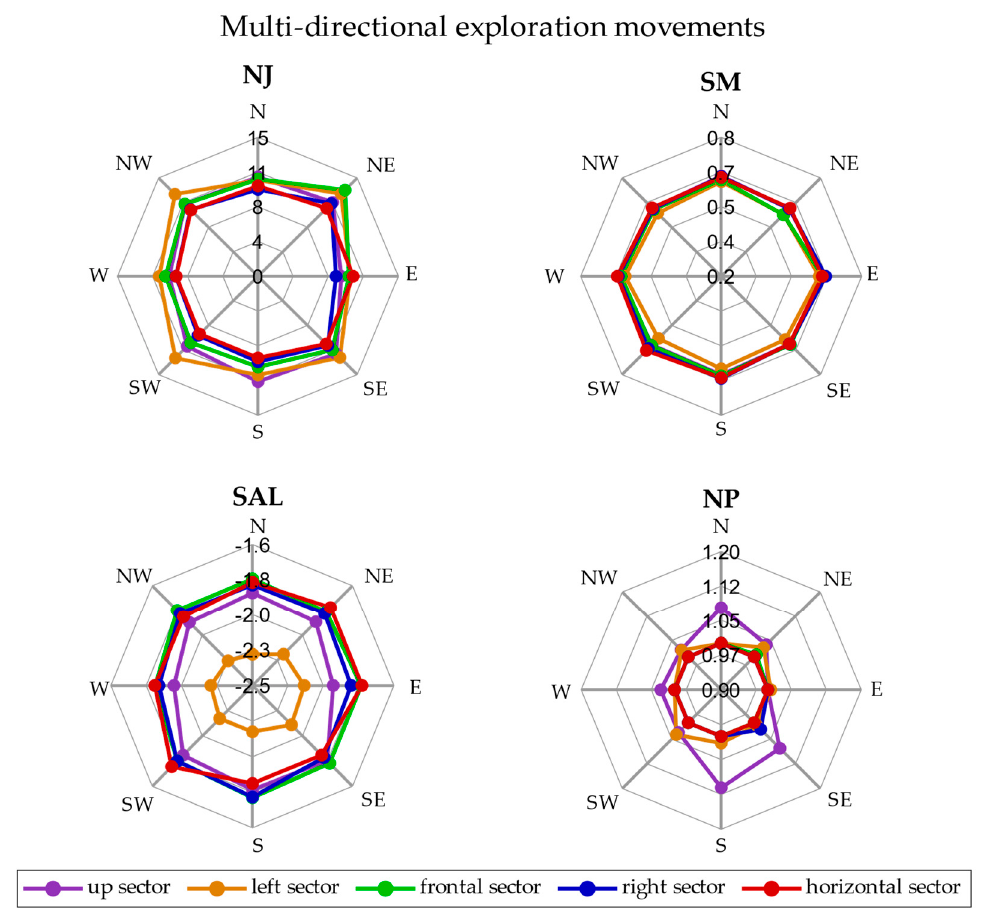
Figure 4. Radar plot for EXP movements. The smoothness metrics are represented in separate plots. In each radar plot, the five sectors—up (purple), left (orange), frontal (green), right (blue) and horizontal (in red)—are reported and each point is the average of the metric across repetitions and subjects.